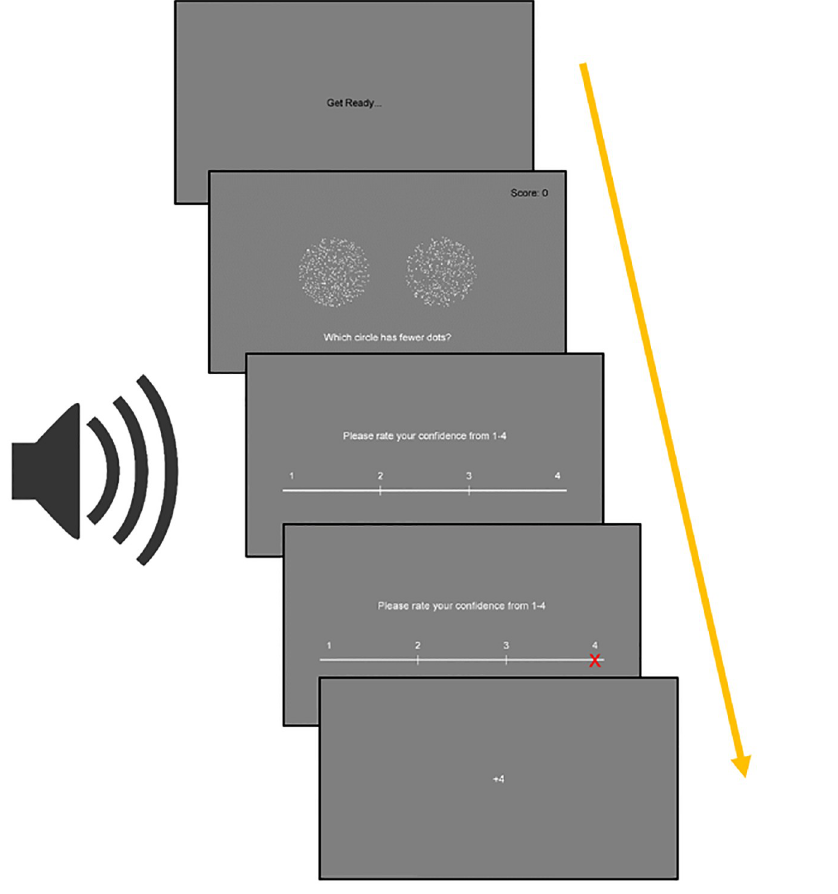
Fig 5. An example of a trial of the metacognition